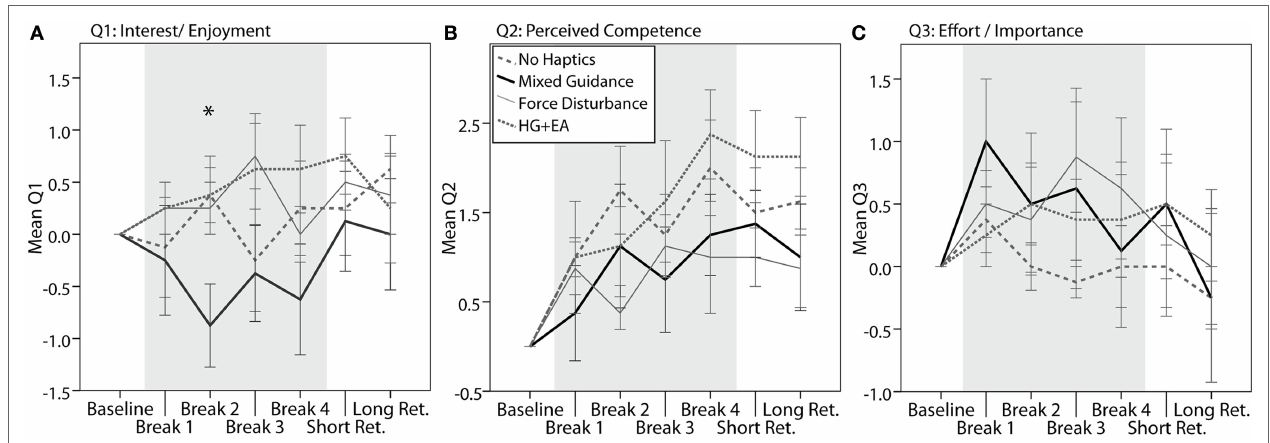
FIGURE 11 | Effect of the training strategies on self-reported motivation . (A) Responses to Q1 (“ I enjoyed playing the game very much ”), after baseline, after every two training blocks, and after short- and long-term retention tests. (B) Responses to Q2 (“ I am satisfied with my performance in the game ”). (C) Responses to Q3 (“ I put a lot of effort into this ”). The shaded areas indicate when the training strategies were applied. All values are referred to the responses provided after baseline. * p < 0.05. Error bars: 1 SE.